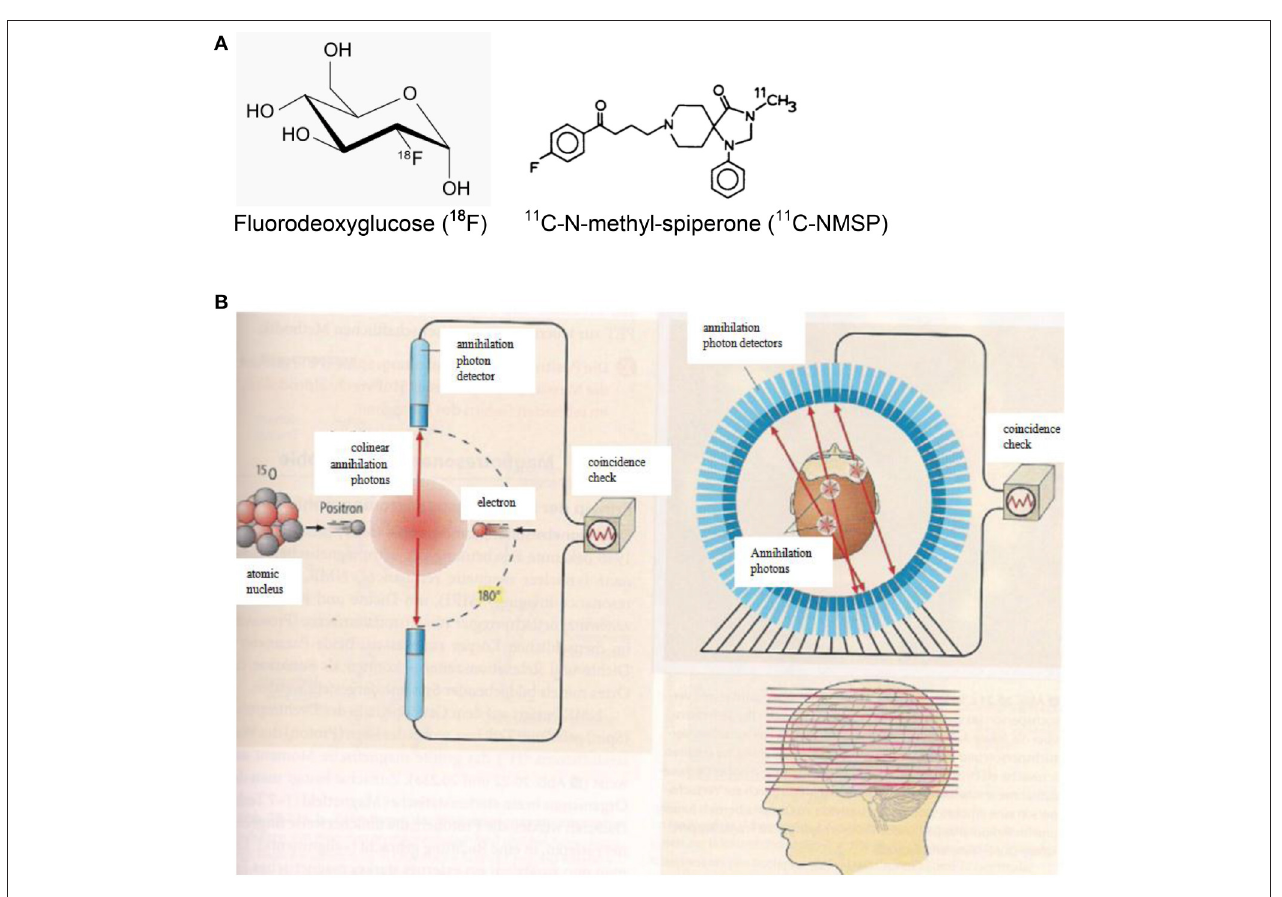
FIGURE 5 | (A) Chemical formulae of two compounds doped with the positron emitters 18 F (left. http://de.wikipedia.org/wiki/Fluordesoxyglucose; 19.12.14) and 11 C (right; http://www.ncbi.nlm.nih.gov/books/NBK23614/ 19.12.14) for PET scans. (B) Principles of positron emission tomography (PET). Left: A positron is emitted from a radioactive nucleus and annihilated with electrons of the tissue emitting two colinear annihilation photons which are monitored by radiation detectors and checked for coincidence. Right: Multi-detector PET scanner taking images (slices) of the concentration of positron emitting isotopes in the brain and thereby measuring